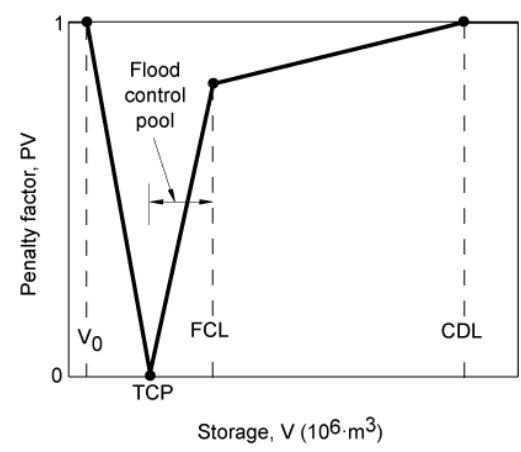
Figure B2 . Example of the storage penalty curve 820 Fig. B2. Example of the storage penalty